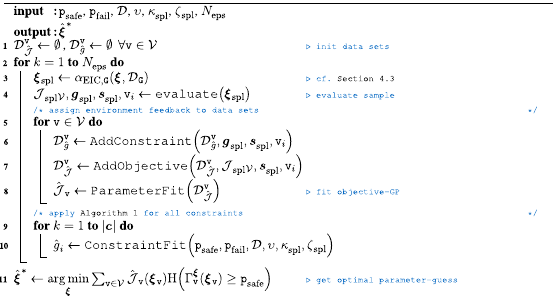
Algorithm 2. Overall BOC